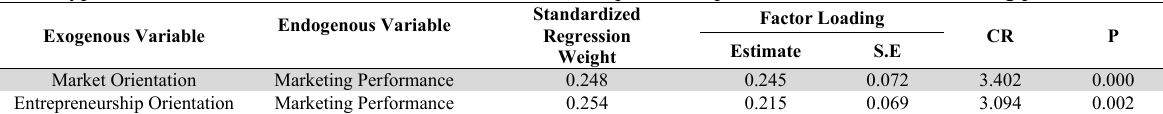
Third Hypothesis SEM Test Results. Market orientation and entrepreneurship orientation towards marketing performance